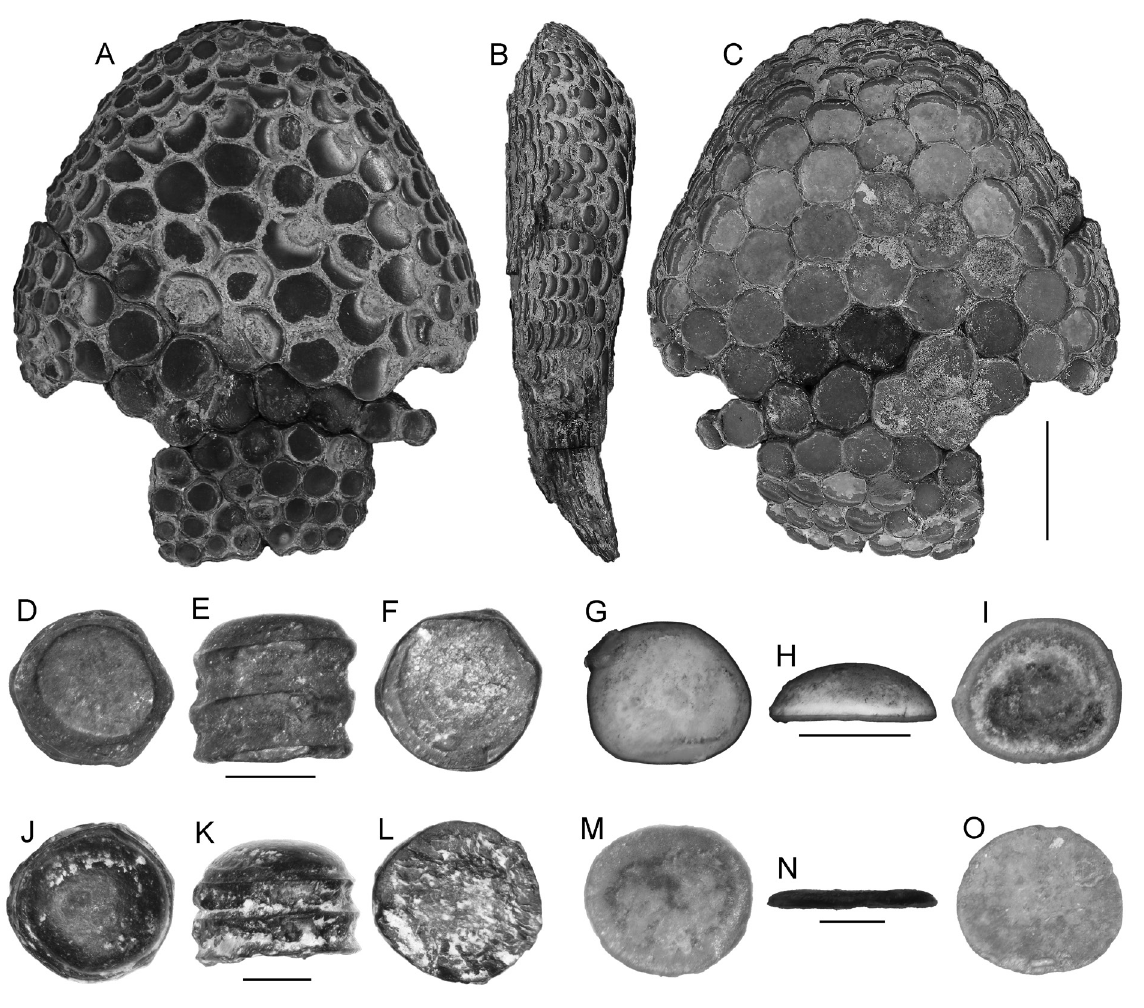
Fig. 58. Egertonia isodonta Cocchi, 1864. A–C . MSC 33348, tooth plate, lower Tallahatta